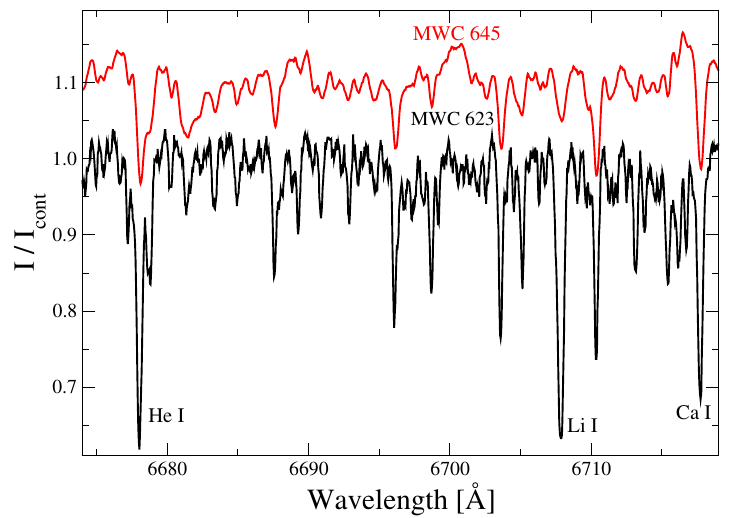
Figure 6. Parts of CFHT spectra of two double-lined binaries, MWC623 (lower) and MWC645 (upper). The He I 6678 Å lines from the spectrum of the hot component (uncertain for MWC645 [15]) as well as the Li I 6708 Å and Ca I 6717 Å lines from the spectrum of the cool component are marked. Other absorption lines are mostly Fe I lines from the cool components. Intensity is normalized to the local continuum, and wavelengths are shown in Å. The wavelength scales are shifted to match the line positions of the cool